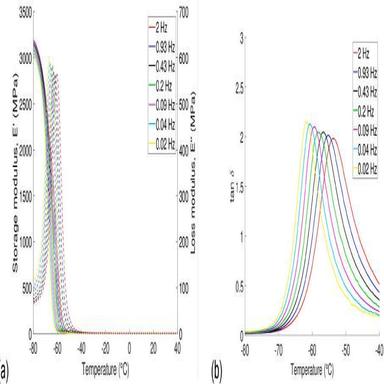
DMA results for F-NR3: (a) temperature dependent storage (solid line) and loss (dashed line) moduli and (b) loss tangents.